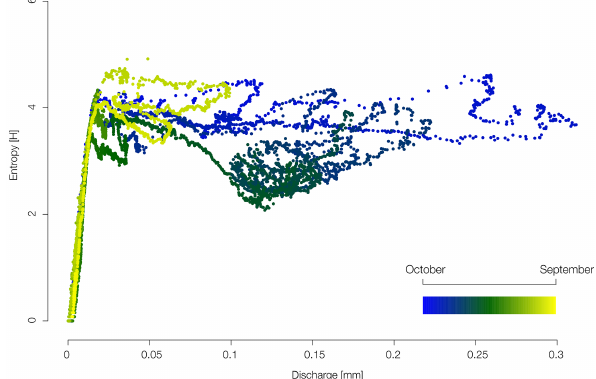
Figure D1. Shannon entropy of the 105 discharge simulations against the area-weighted median of the discharge simulations. The color key ranges from blue (winter) to green (autumn–spring) and to yellow (summer) and illustrates the time of the